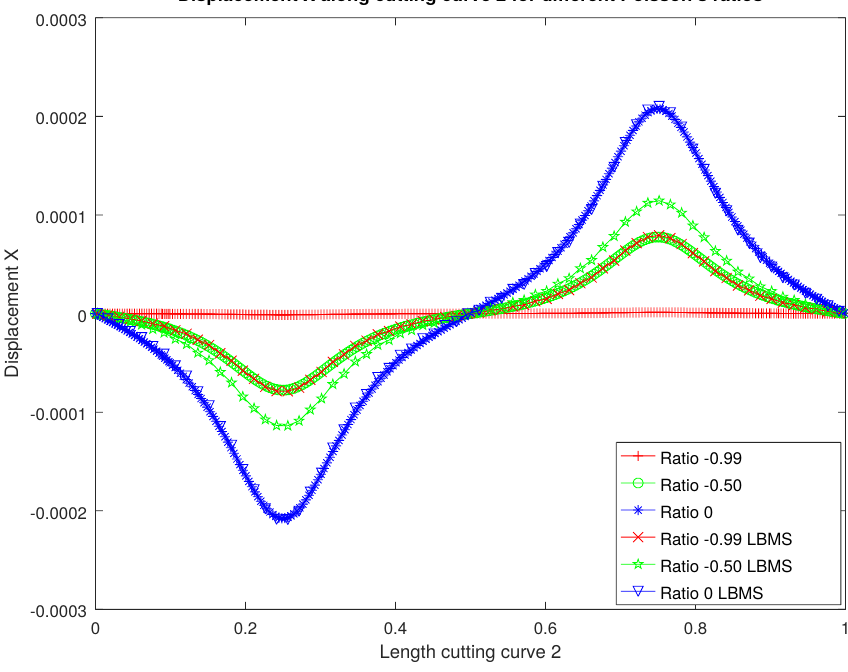
Figure A6. First displacement components along cutting curve C 2 for negative Poisson’s